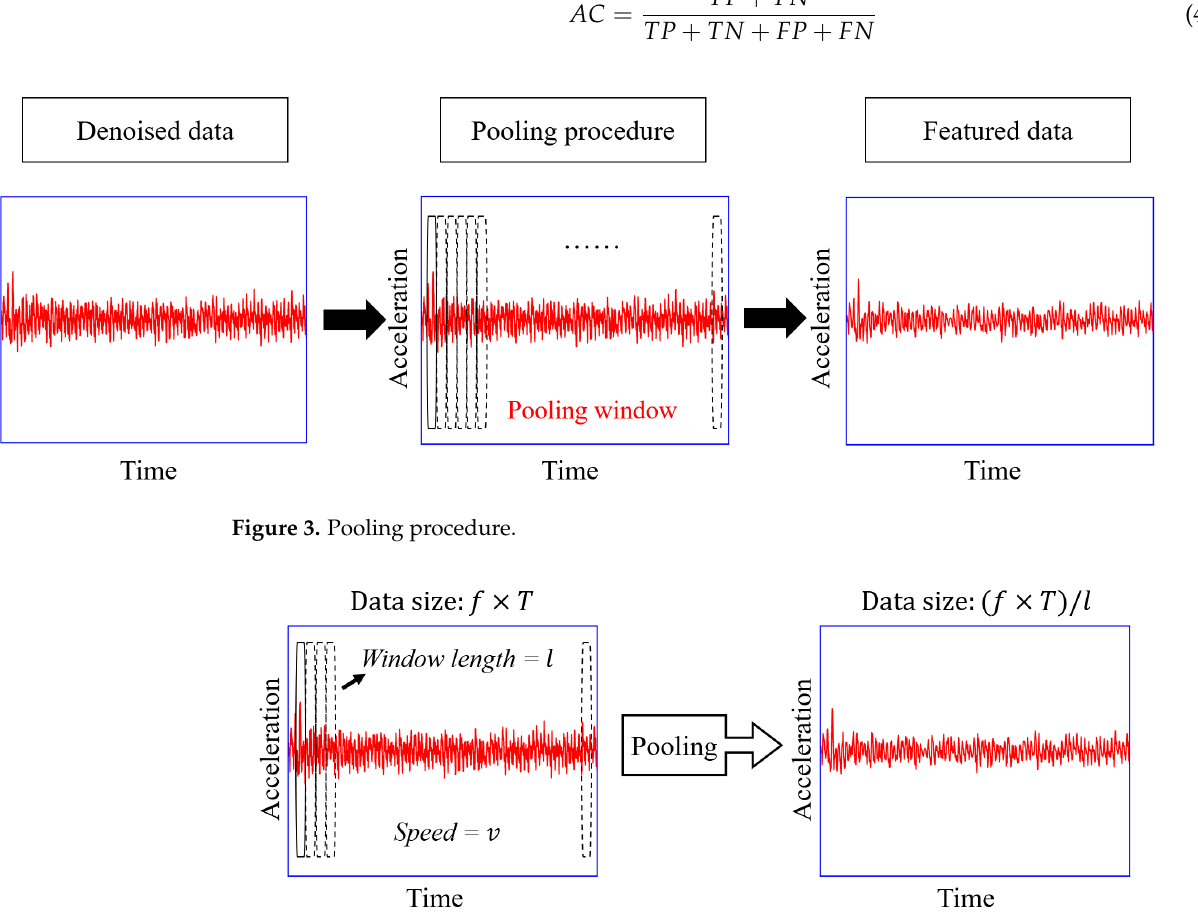
5 of 20 Figure 2. Data acquisition with fi ltering operation. 2.3. Pooling Procedure The pooling operation further processes the denoised data from the fi ltering proce- dure, as shown in Figure 3. The concept of the pooling procedure can refer to the pooling layer in the neural network [39], where the pooling operation retrieves the representative features, such as the maximum value and mean value, within a certain neighborhood along the time-series direction. The data’s characteristics remain mostly unchanged throughout the pooling process, despite a reduction in data size [40]. Figure 4a illustrates how the operation pools the data of the vehicle traveling at speed 𝑣 . The passing time is 𝑇 , the sampling frequency is 𝑓 , and the data size is 𝑓 × 𝑇 ; Figure 4b shows the pooling process on the car with speed 𝑠 × 𝑣 , in which the speed ratio of the run to the fi rst is 𝑠 , and its data size is computed as (𝑓 × 𝑇)/𝑠 . Through the pooling process, data of the same size can be acquired by modifying the window length, 𝑙 , according to speed variations;